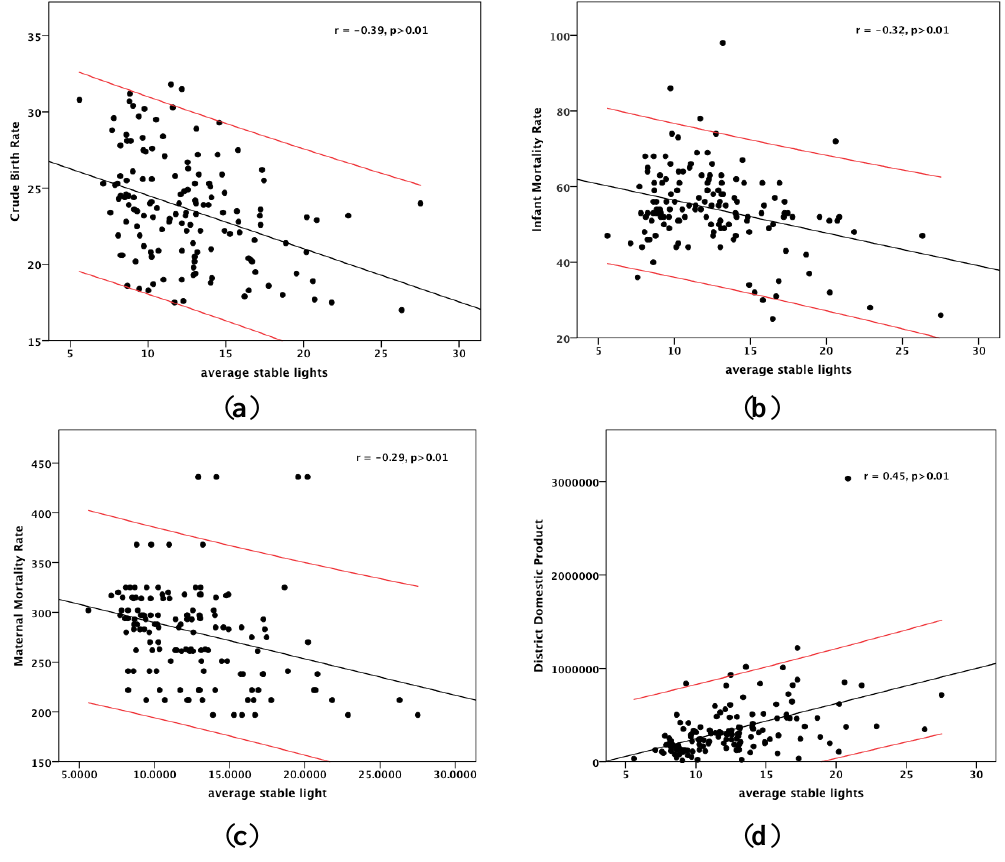
Figure 3. Correlations between health indicators and average stable lights,